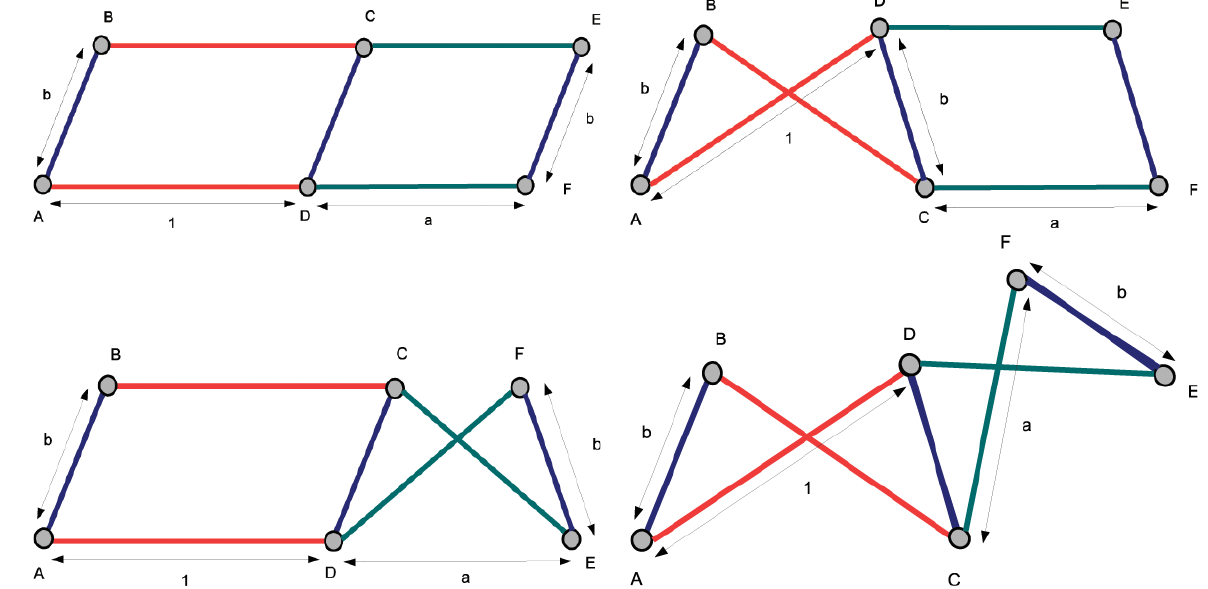
Figure 3. The 4 di ff erent modes of the system (Eq. 8) corresponding to the decomposition (Eq.